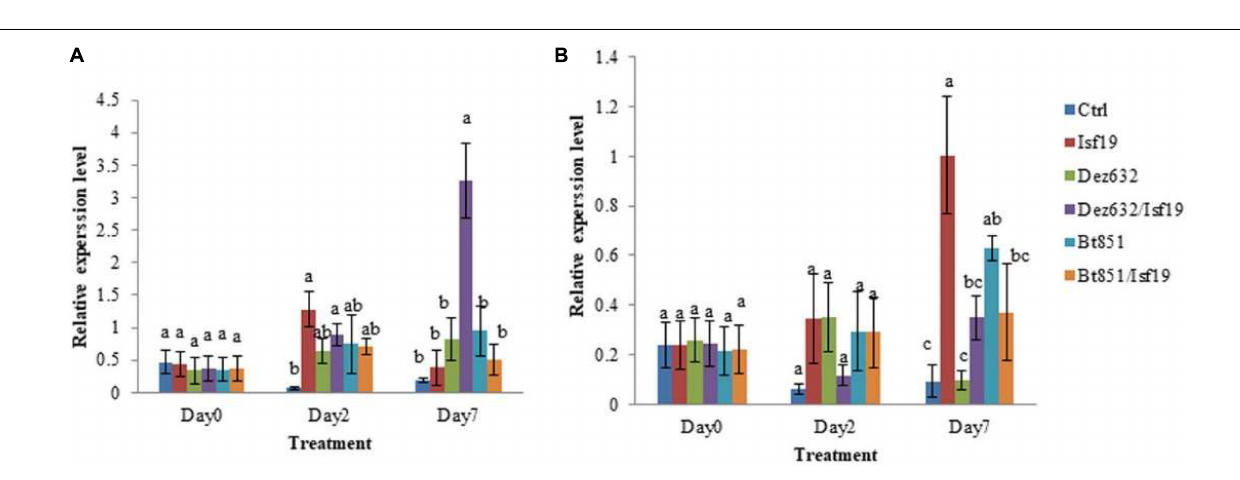
FIGURE 7 | Relative expression levels of PR1 (A) and NBS-LRR2 (B) defense-related genes in the non-inoculated sugar beet root slices (Ctrl), root slices treated by Pantoea sp. Dez632 , Pseudomonas sp. Bt851, and/or B. pumilus Isf19. Results represent the means of three replicates. Vertical bars indicate standard errors (SE), and different letters at each day after treatment indicate statistically significant differences between treatments at probability levels of